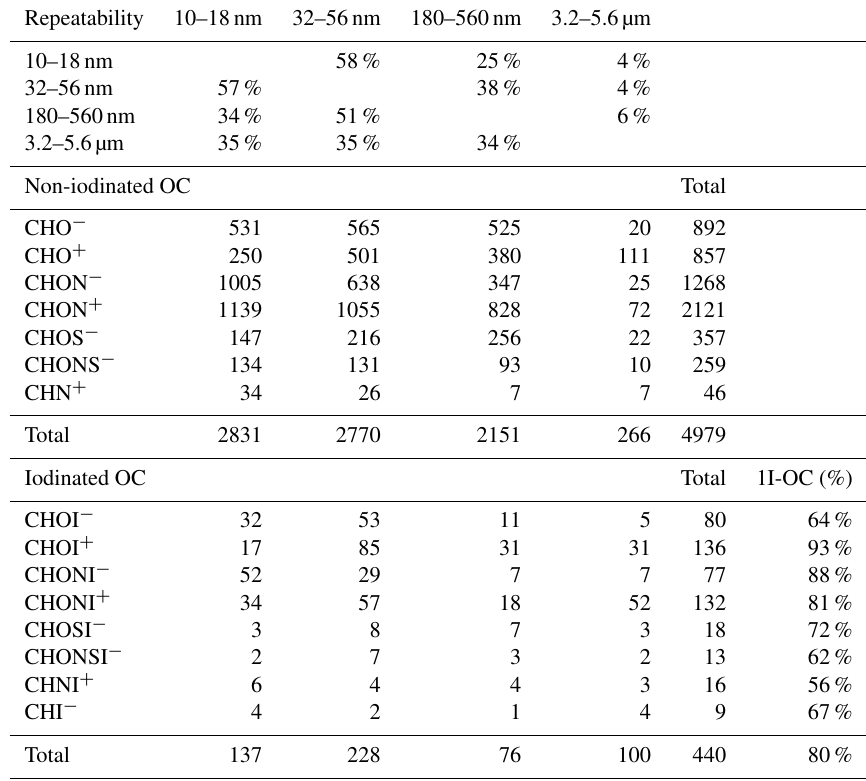
Table 2. The numbers of assigned formulas of elemental groups of organic compounds in 10–18nm, 32–56nm, 180–560nm and 3.2–5.6µm size bins. The first four rows show the percent of formula repeatability between two size bins. 1I-OC: molecular formula containing one iodine